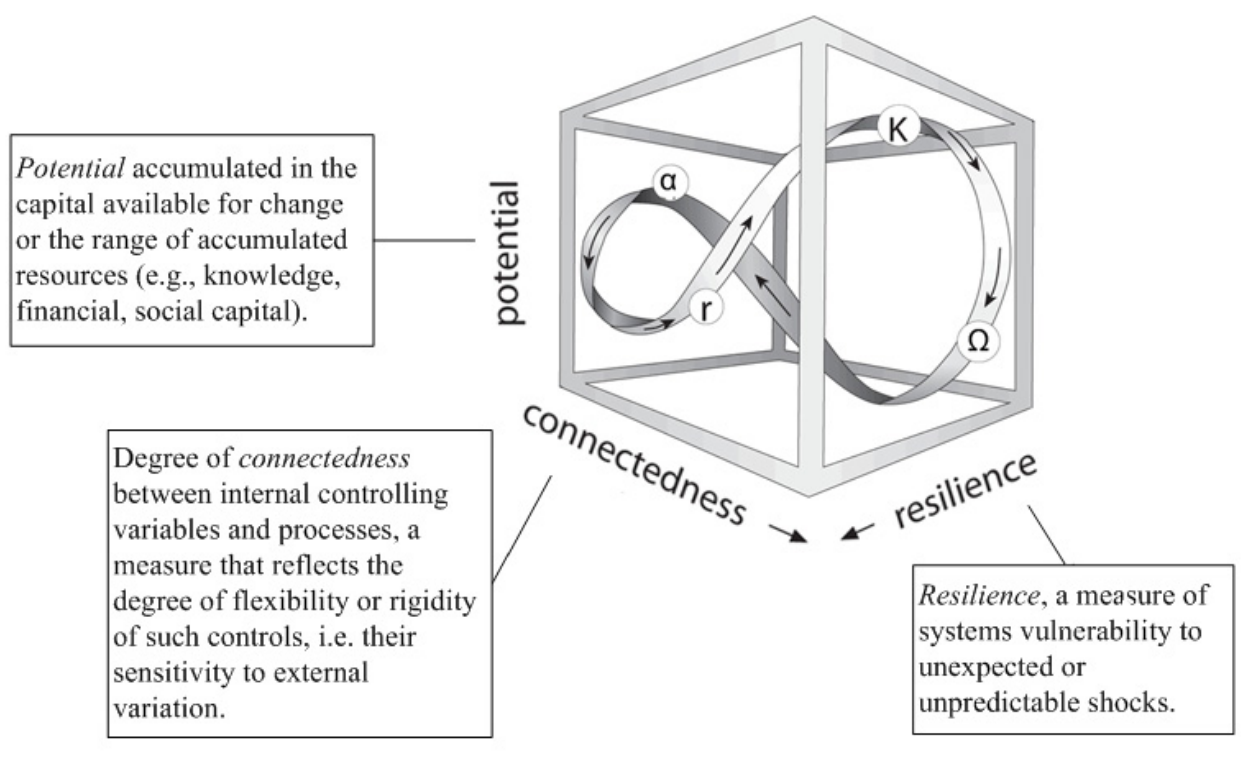
Fig. 2 . The adaptive cycle. Modified from Holling and Gunderson (2002) with permission from Island Press, Washington, D. C.,